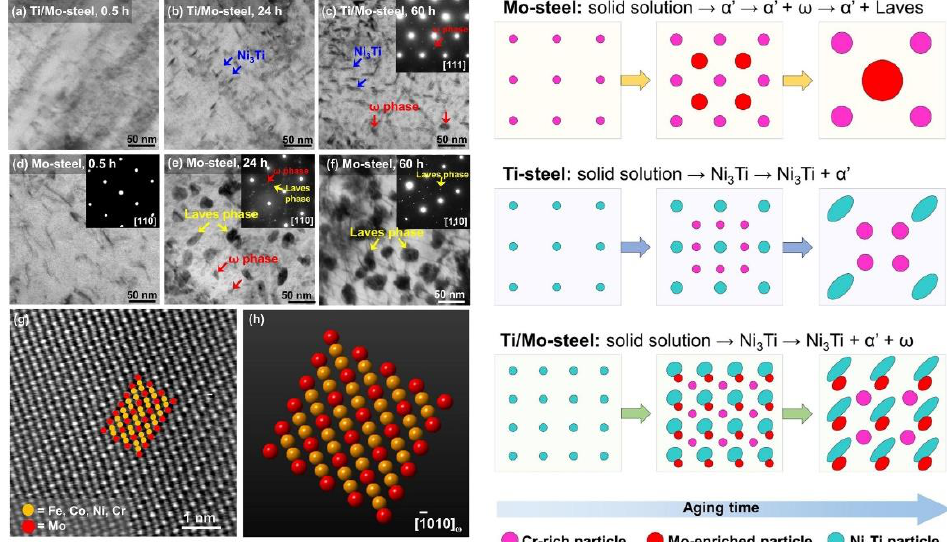
Figure 8. TEM and STEM measurements of the Ti/Mo- and Mo-steels under distinct aged processes and corresponding to the evolution mechanisms: ( a ) Ti/Mo-steel, 0.5 h, ( b ) Ti/Mo-steel, 24 h, ( c ) Ti/Mo-steel, 60 h, ( d ) Mo-steel, 0.5 h, ( e ) Mo-steel, 24 h, and ( f ) Mo-steel, 60 h. ( g ) Presents an HAADF-STEM micrograph of a ω precipitate in ( e ), and ( h ) displays the simulated atomic structure of ω phase [ 131]. (Reprinted with permission from Ref. [131]. Copyright 2021 Elsevier).